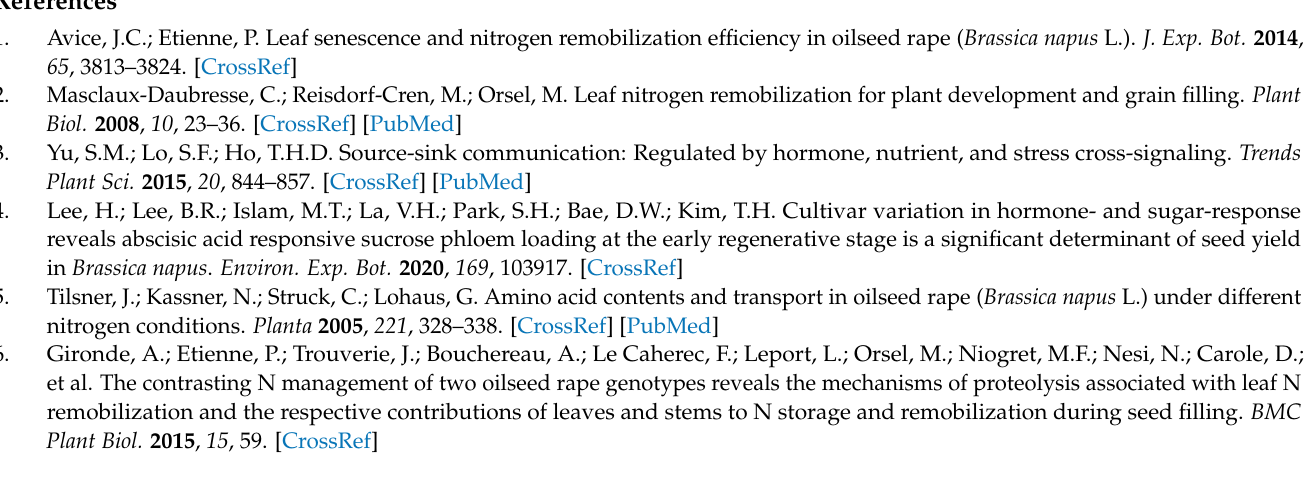
Supplementary Materials: The following are available online at https://www.mdpi.com/article/ 10.3390/plants10081670/s1, Figure S1: Schematic diagram of the experimental design. Ethephon was foliar-sprayed at the bolting stage of Brassica napus . After 10 days of ethephon treatment, mature leaves ranked 4–12 (i.e., rank 1 designated as the oldest leaf) of Brassica napus were harvested, Figure S2: Fructose (A) and glucose content (B) in mature leaves in control or ethephon-treated plants for 10 days. Data are presented as mean ± SE ( n = 3). Significant differences between treatments are represented by * P < 0.05, ** P < 0.01, *** P < 0.001, Table S1: Primer sequences used for qRT-PCR